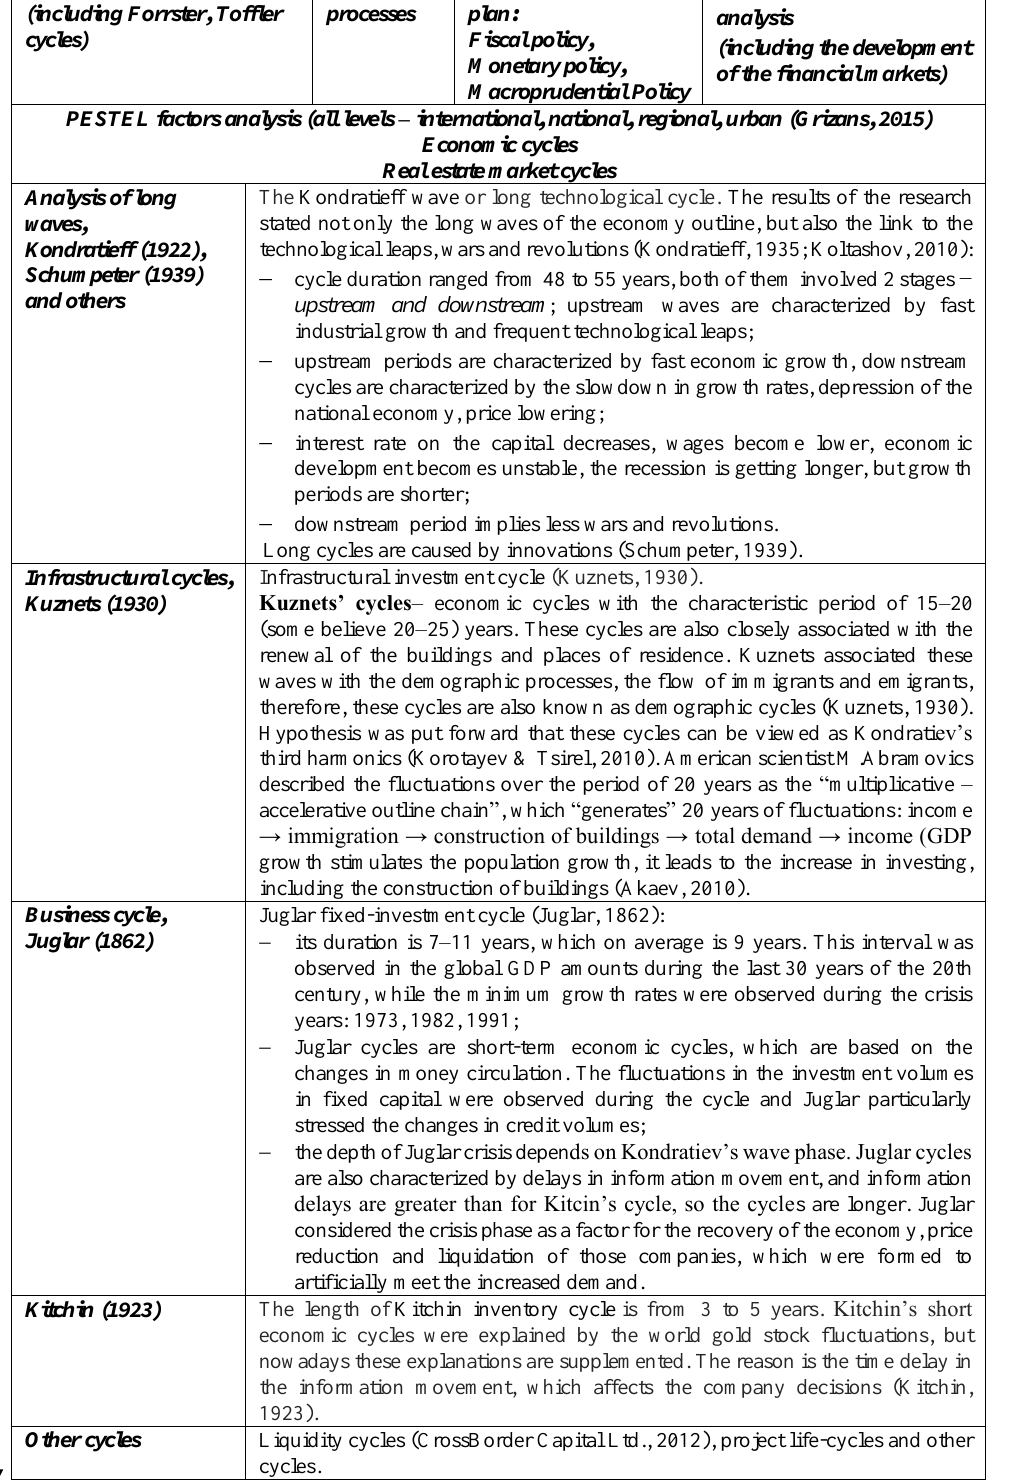
Fig. 3. System of cycle information analysis (Figure created by